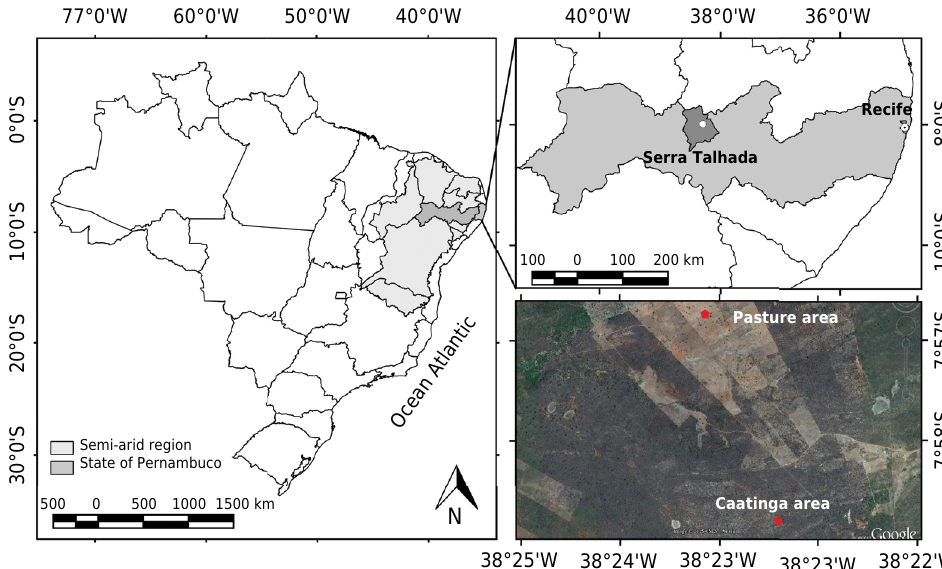
Figure 1. Location of experimental fields of Caatinga and degraded pasture in the semi-arid region of